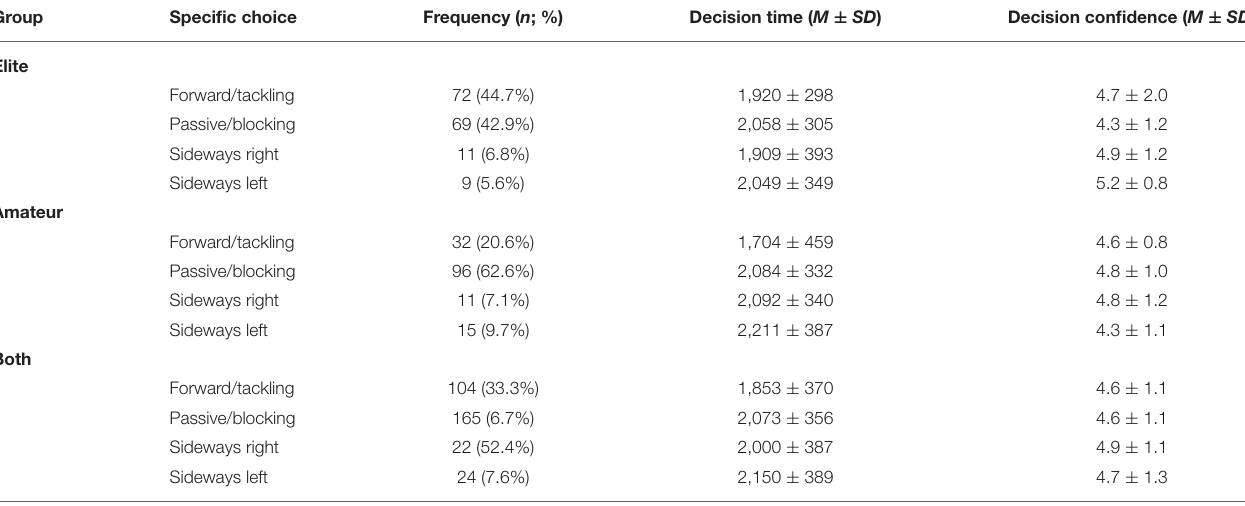
TABLE 1 | Frequency of specific choice and the respective decision time (in ms) and decision confidence (Likert-type scale) in both player groups. Group